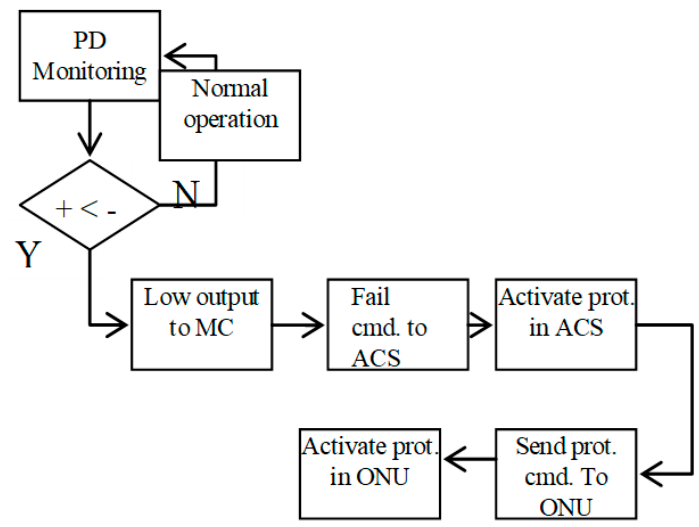
Figure 13. Protection and restoration process flow.